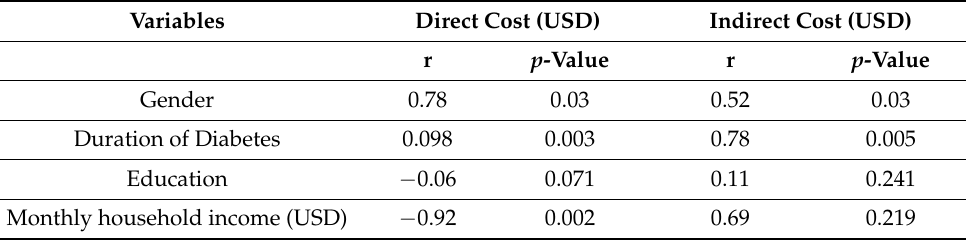
Table 3. Correlation among cost of diabetes management and sociodemographic